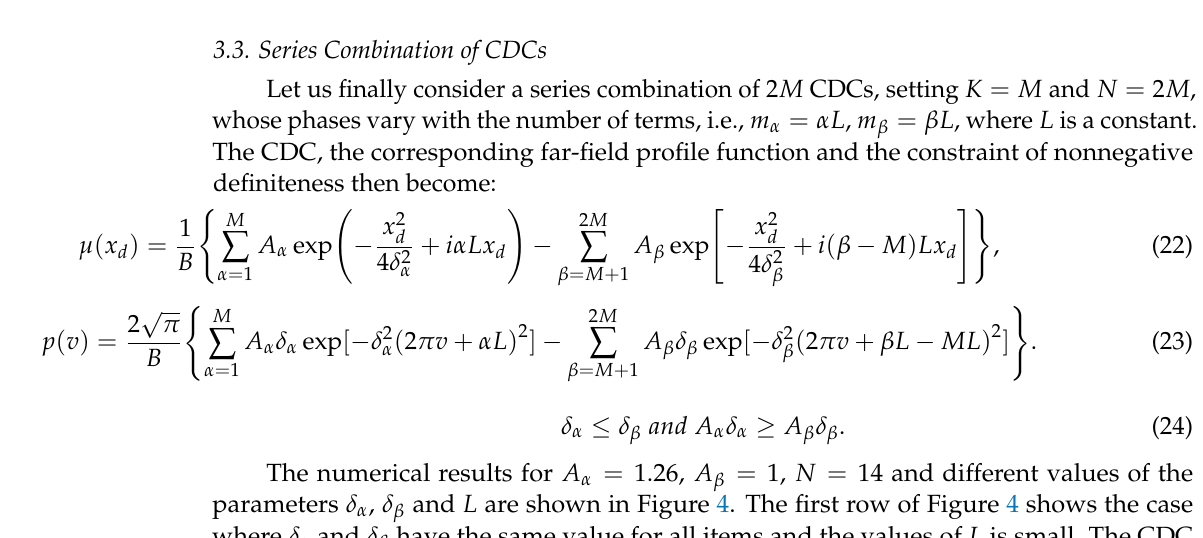
Figure 3. The source coherence states calculated from Equation (19) and far-field spectral densities calculated from Equation (20) for different values of the source parameters m and n : ( a – c ) m = 9 π /10, n = 0; ( d – f ) m = 9 π /10, n = π /10; ( g – i ) m = n = 9 π